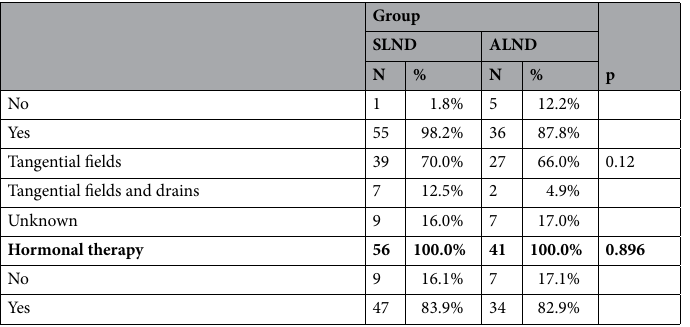
Table 2. Demographic and clinical characteristics of the patients. Bold values indicates category headings and the total value of the category by group. T0 no evidence of primary tumor, Tis ductal carcinoma in situ, T1 tumor size is 2 cm or less across, T2 tumor size 20–50 mm, T3 tumor size is more than 5 cm across, N0 i + the area of cancer spread contains fewer than 200 isolated tumor cells and is smaller than 0.2 mm (cancer cells seen in routine stains or immunohistochemistry), N1mi micrometastasis to lymph node, N1 1–3 lymph nodes affected, N2 4–9 lymph nodes affected, N3 10 or more lymph nodes affected, ER estrogen receptor, HER2 human epidermal growth factor receptor 2, PR progesterone receptor. *This patient had her whole 0.5 cm invasive tumor removed during percutaneous biopsy. However, she was later classified clinically as T1a. a Chi- squared or Fisher’s exact test.